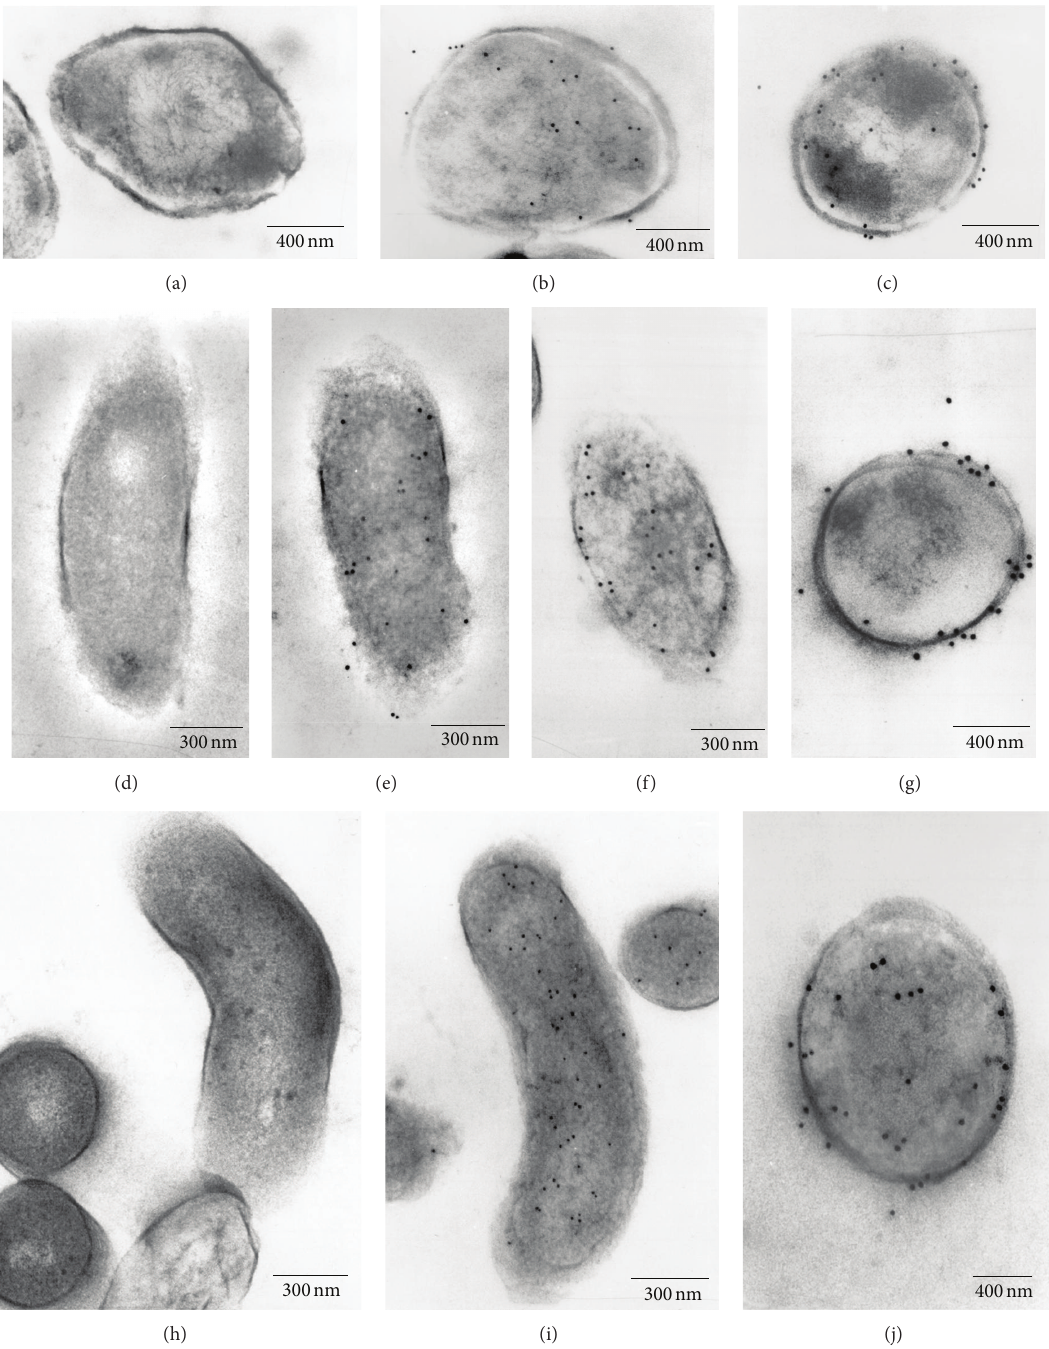
Figure 3: Localization of MCR in Methanosarcina mazei (DSM 3647; a, b, c), Methanothermobacter marburgensis (d–g), and Methanother- mobacter wolfei (h, i, j). On media without nickel depletion, the markers are localized in the cytoplasm (b, e, i). On nickel-depleted media with levulinic acid (c, f: 0.05 M; g 0.2 M; j: 0.1M levulinic acid) a tendency to membrane localization is obvious (a, d, h are negative controls).